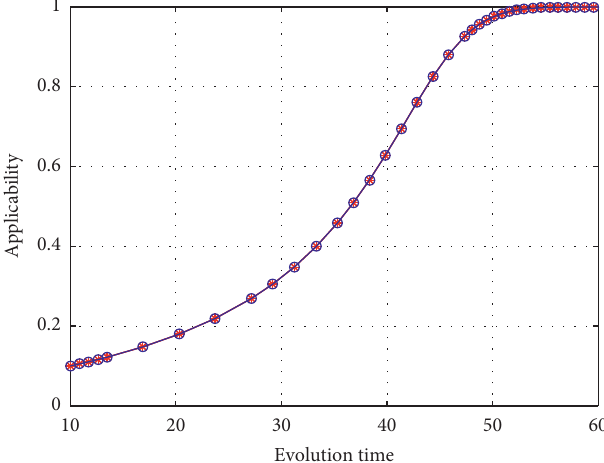
Figure 5: Curve of image recognition model applicability and iteration times.